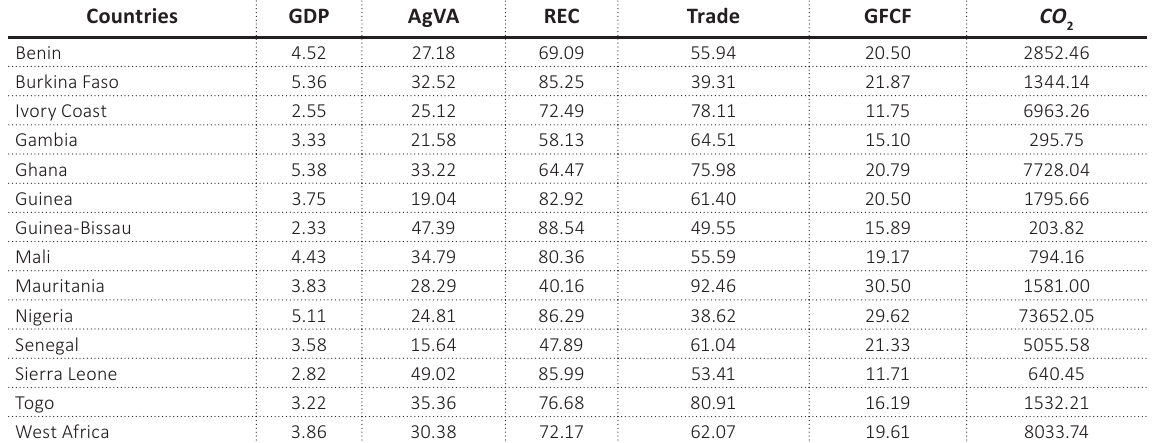
Table 1. Average annual of the variables used in the study (1990–2015)